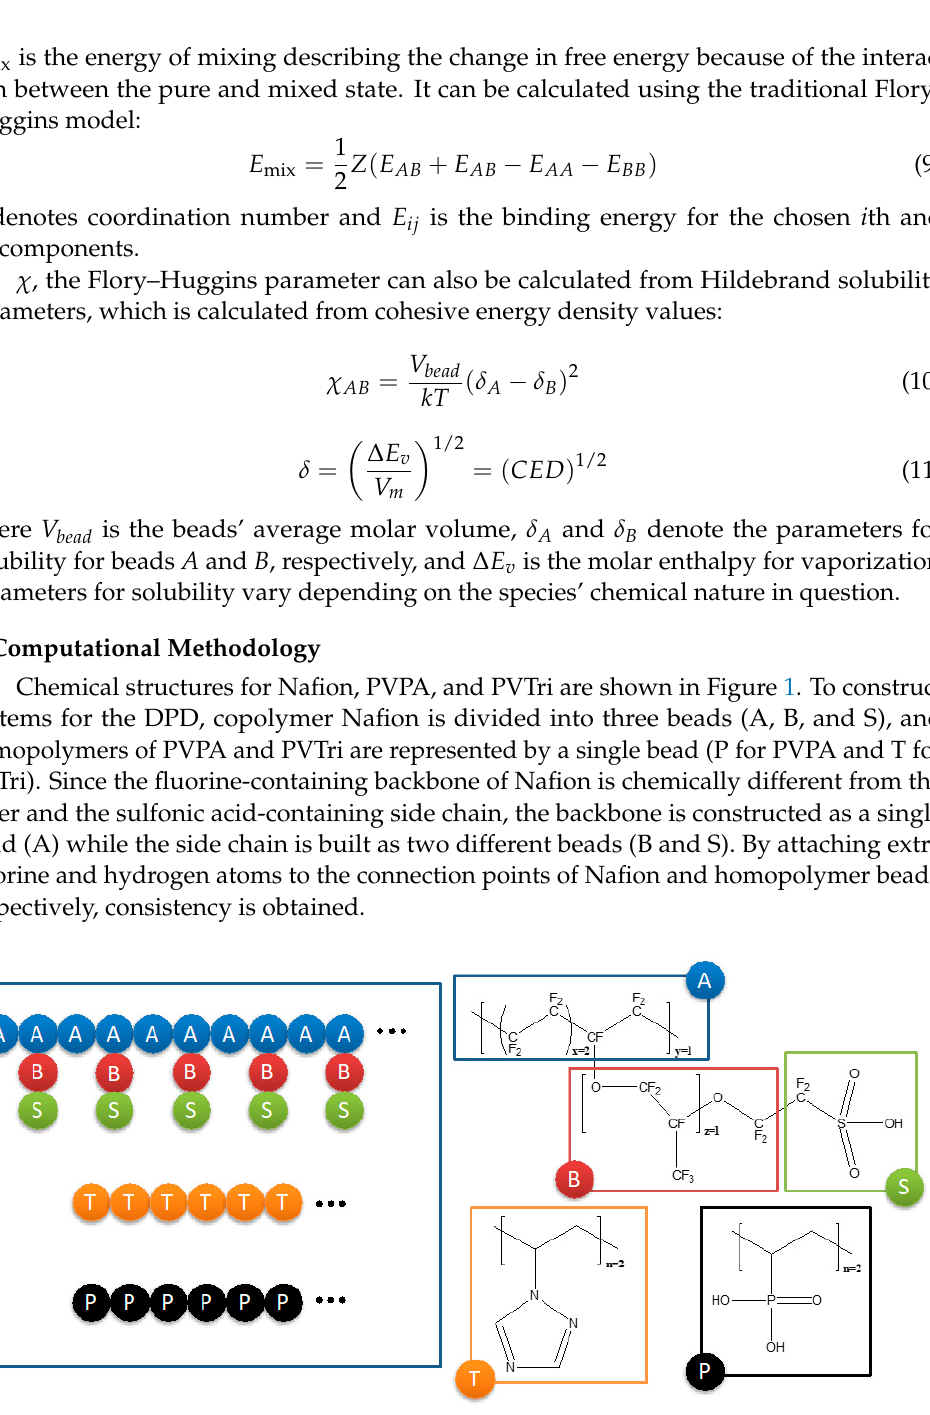
Figure 1. Chemical structures of Nafion, poly(1-vinyl-1,2,4-triazole) (PVTri), and poly(vinyl phos- phonic acid) (PVPA) and structure of beads of polymers used in dissipative particle dynamics (DPD)